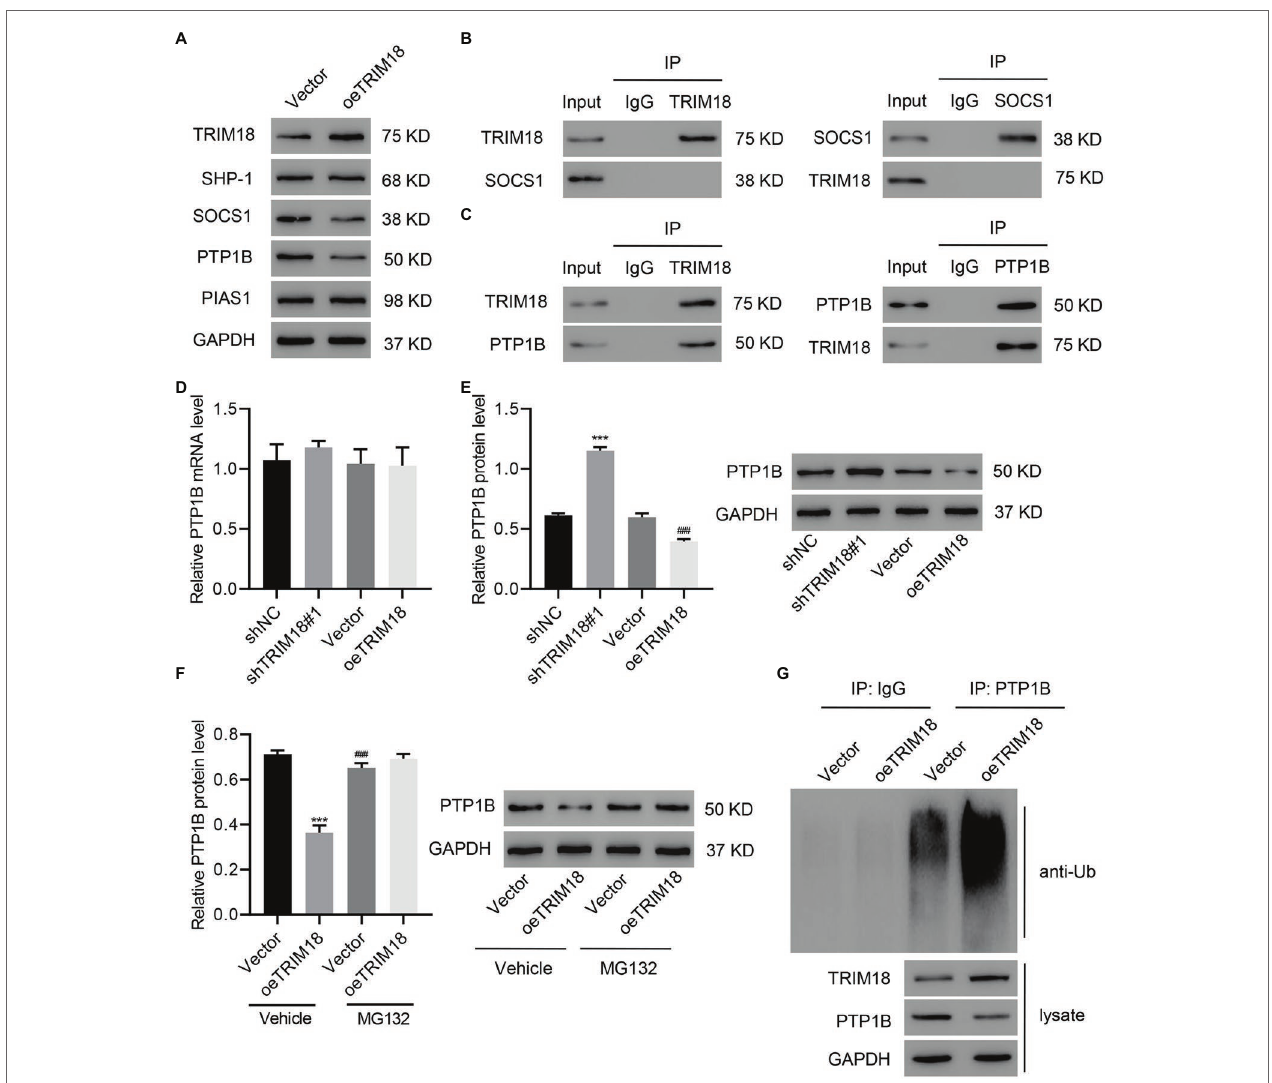
FIGURE 5 | TRIM18 interacts with protein tyrosine phosphatases (PTP1B) and promotes PTP1B ubiquitination. (A) HK-2 cells were treated with HG and transduced with indicated vectors, and then TRIM18, SHP-1, SOCS1, PTP1B, and PIAS1 expression was measured. (B,C) Cell lysates were immunoprecipitated and then blotted with the indicated antibodies. (D–F) Cells were transduced with indicated vectors with/without 10 μ M MG132, and then PTP1B expression was measured. (G) PTP1B was immunoprecipitated and immunoblotted. Values are presented as mean ± SD. n = 3/group. *** p < 0.001 vs. shNC or vector+vehicle. ### p < 0.001 vs.